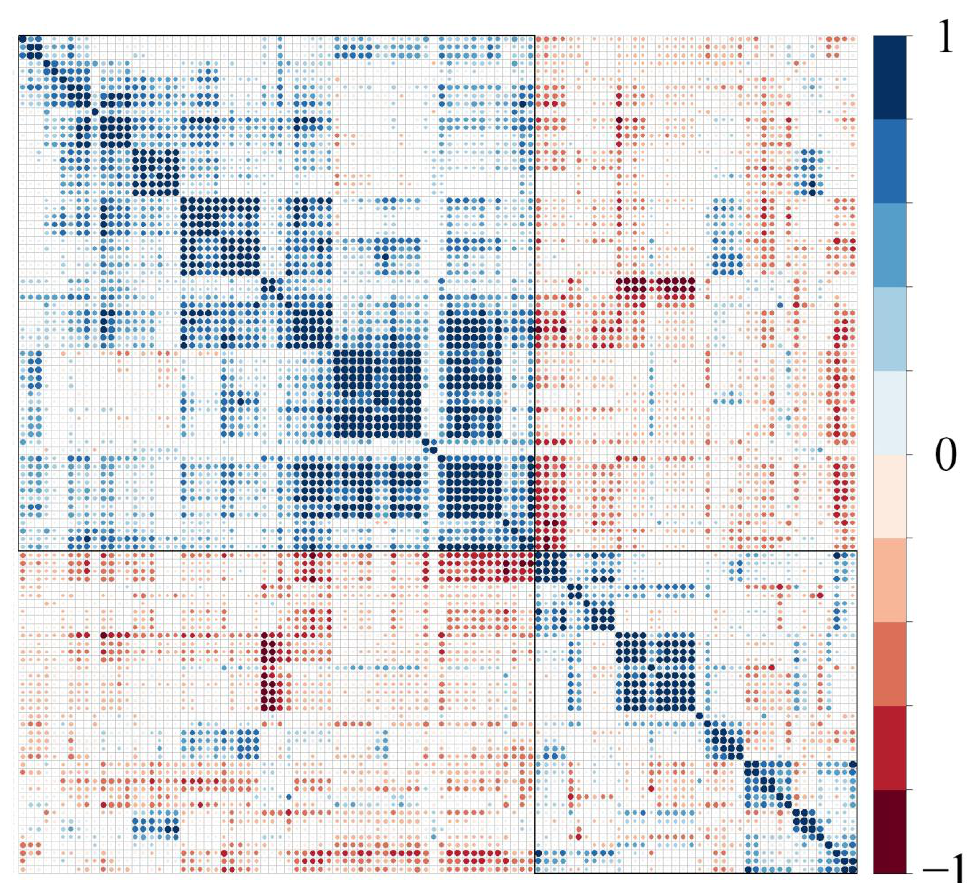
Figure 5. Correlation map of variables selected by RF for integrated analysis of the microbiome and metabolome, where the red color and blue color represent negative correlation and positive correlation, respectively.